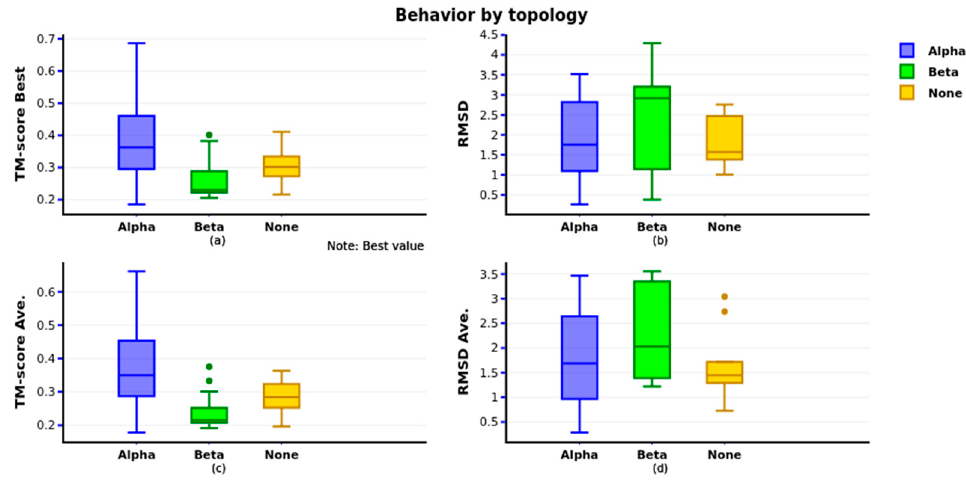
Figure 8. GRSA2-SSP according to the type of secondary structure.